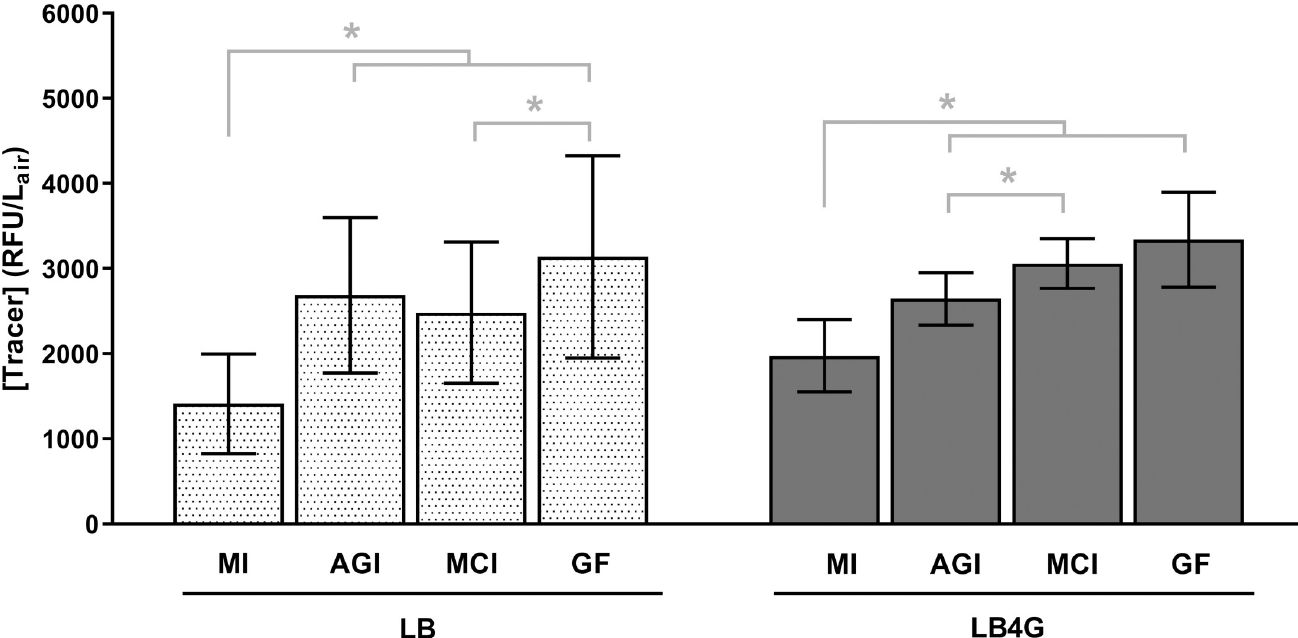
Fig 2. Tracer aerosol concentrations. Aerosol concentrations varied significantly by sampler type (P < 0.0001), but neither the suspension medium nor the interaction of sampler and suspension medium were significant factors (P = 0.3977 and P = 0.0961, respectively). Tracer aerosol concentrations measured by midget impingers were lower than all other samplers for aerosols of both LB and LB4G. Small but significant differences were present between the Mercer cascade impactor and either the gelatin filters (LB aerosols), or the AGI (LB4G aerosols). Significant differences by Tukey’s multiple comparisons post-test are indicated by an asterisk. MI = midget impinger, AGI = All Glass Impinger, MCI = Mercer cascade impactor, GF = gelatin filter.